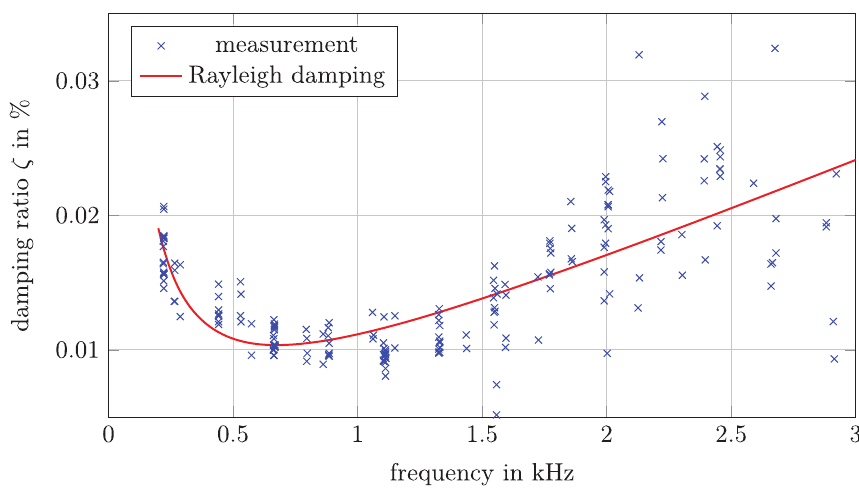
Figure 4. Identi fi ed damping ratios over frequency for several experiments and fi tted Rayleigh damping curve.